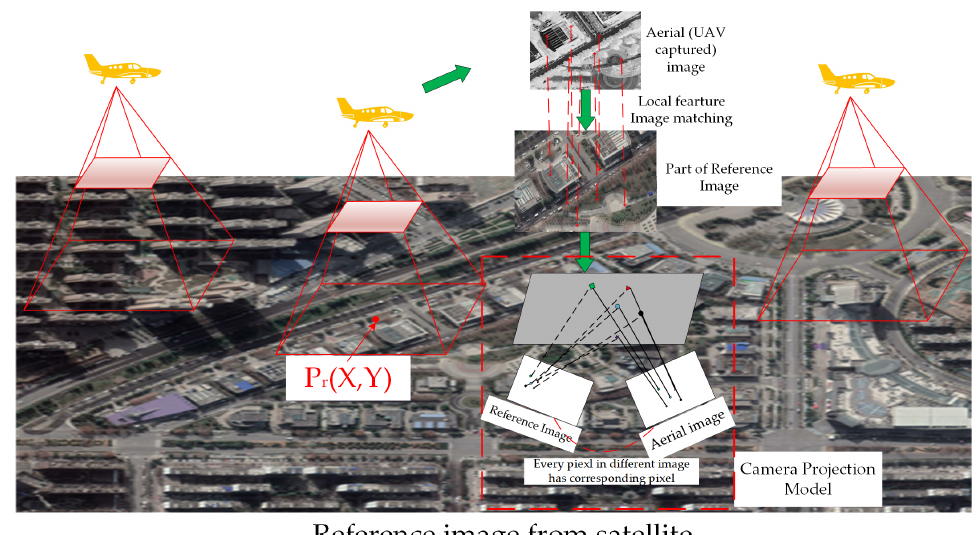
Figure 1. A sketch of the UAV navigation technique based on image matching. When the images are captured from the high altitude, it can be assumed that the spatial points in the real-world will all fall in the same plane, approximately.